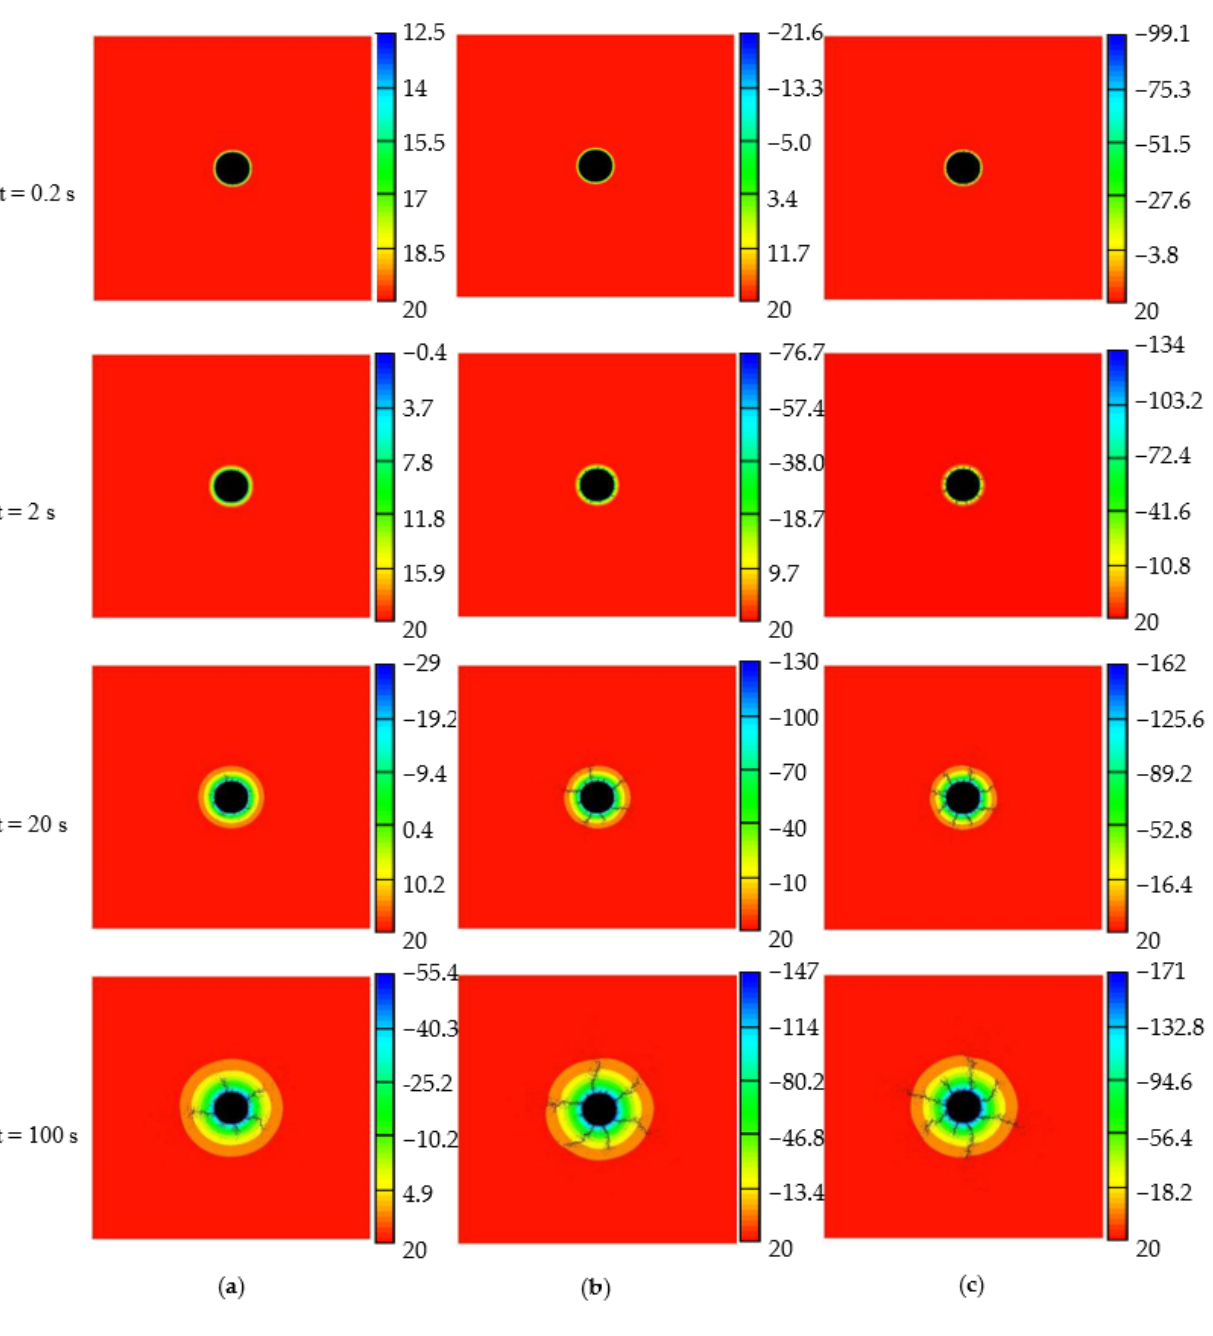
Figure 17. Temperature distribution and crack propagation in the circular hole plate models with different heat exchange coefficients (unit: °C). ( a ) H = 100 W · m − 2 · K − 1 ; ( b ) H = 500 W · m − 2 · K − 1 ; ( c ) H = 1000 W · m − 2 · K − 1